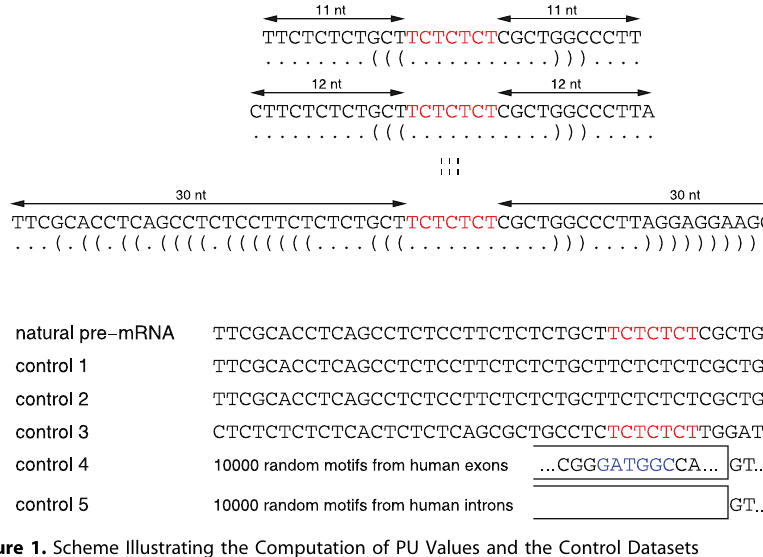
Figure 1. Scheme Illustrating the Computation of PU Values and the Control Datasets (A) The figure shows a silencer site (red) bound by the polypyrimidine tract binding protein in the intron upstream of the mouse c-src exon N1 [53] together with 30 nt of its up- and downstream pre-mRNA sequence context. We computed PU values of the splicing motif for all context lengths from 11 nt up to 30 nt. The optimal secondary structure in dot-parenthesis notation is shown below the sequence. To get a single value that measures the single-strandedness of this motif, we averaged these 20 values. (B) Controls: Given an experimentally verified splicing motif (red) and its natural pre-mRNA context, we randomly selected a substring (blue) with the same length from the flanking regions in control 1. In control 2, we copied the verified motif to a randomly selected position. In control 3, we modified the flanking regions by dinucleotide shuffling [28]. The dataset in controls 4 and 5 consists of 10,000 randomly selected motifs (blue) from human exons (shown as open boxes) and introns (lines),